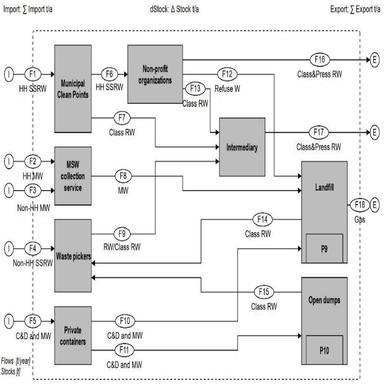
General system for Tandil constructed with the software STAN (goods layer). Subsequent layers with each waste category under study were created (see Supplementary Information). RW ¼ Recycling waste; Class RW ¼ Classified recycling waste; Class&Press RW ¼ Classified and pressed recycling waste; C&D ¼ Construction and demolition waste; MW ¼ Mixed waste.